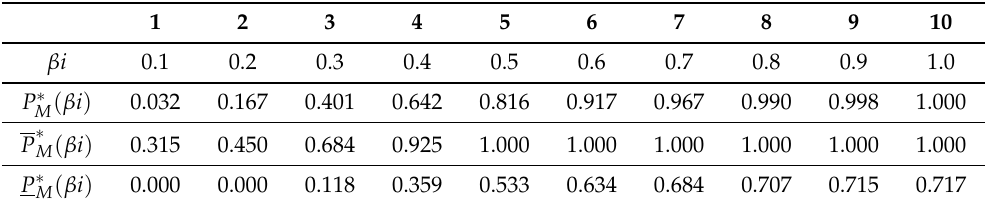
Table 11. Distribution function